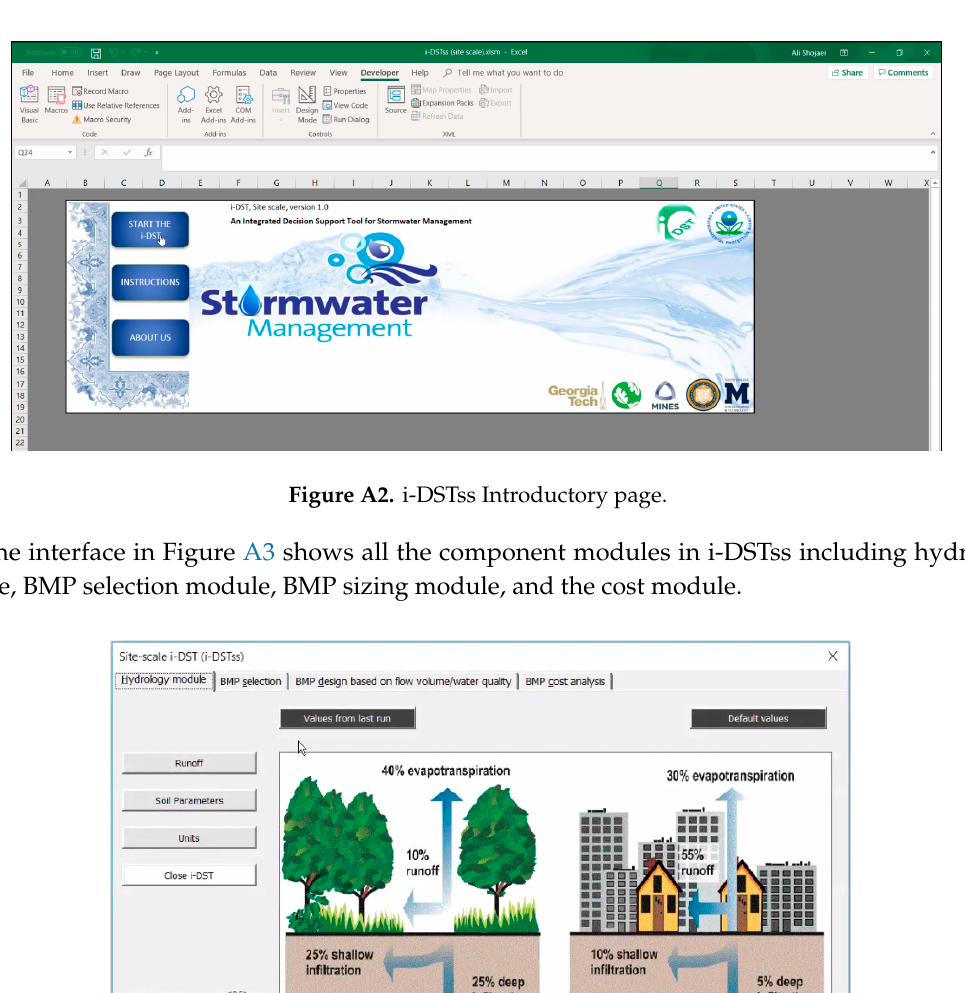
Figure A1. Flowchart describing i-DSTss